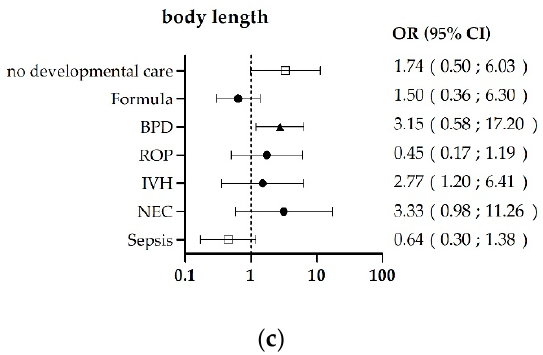
Figure 2. Influence of risk factors on mental, psychomotor, and somatic outcomes of 256/391 children examined after 24 months. Of these, 166 showed risk factors for growth retardation and/or mental and psychomotor deficits. The multivariate regression analysis of the somatic parameters and scores in the Bayles Scales of Infant Development II showed significant deficits ( ▲ ). ( a ) Exclusive formula feeding was associated with a 3.62- fold increased risk of developmental deficits in mental ( n = 43) and ( b ) a 4.57-fold increased risk of developmental deficits in psychomotor development ( n = 43). ( c ) BPD was associated with a 2.77-fold increased risk of growth retardation (length, n = 63). □ p > 0.05, ● p > 0.12 Abbrevia-